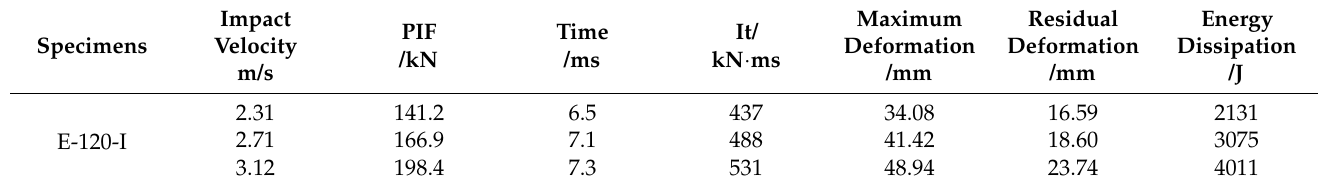
Figure 8. Column top displacement time histories. ( a ) E-120-I; ( b ) E-120-U; ( c ) E-180-I; ( d ) E-180-U; ( e ) C-180-I. Table 2. Summary of the key results of the experimental CFT columns.